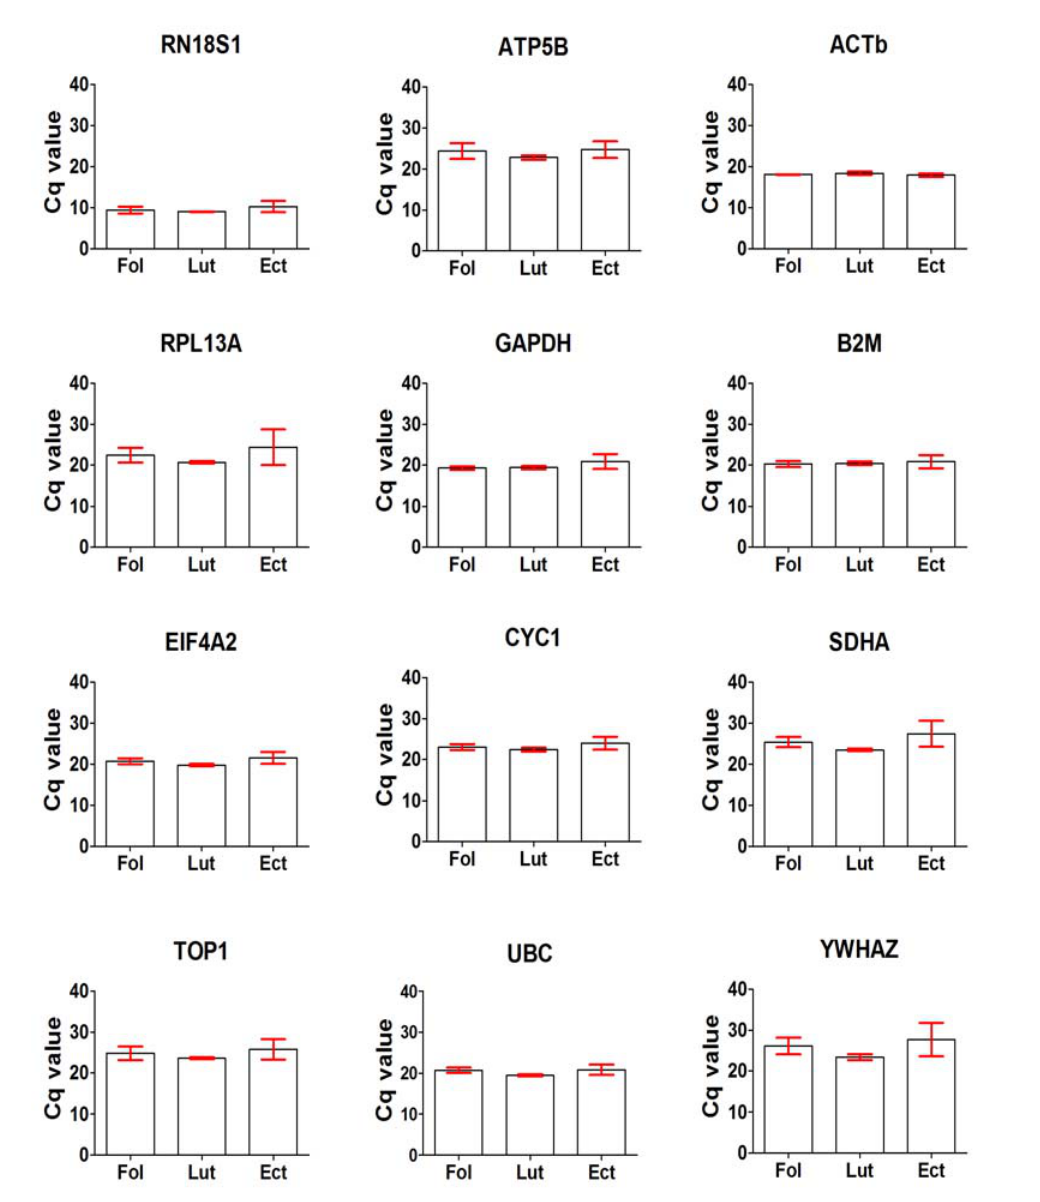
Figure 1. Expression levels of the 12 reference genes evaluated as shown by their Cq values in 12 fallopian tube samples. Samples were from the follicular (Fol, n = 4), luteal (Lut, n = 4) phase and ectopic pregnancy (Ect, n = 4). Cq values were obtained from the data output file of ABI PRISM 7000 and are inversely proportional to amount of mRNA template material